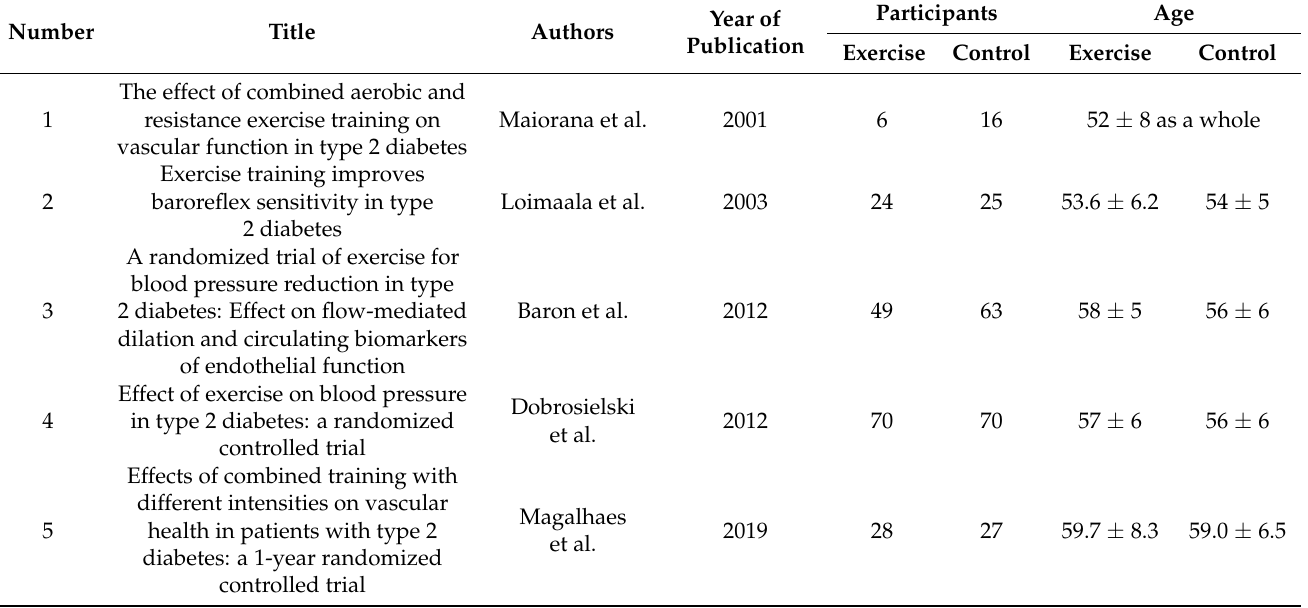
Table 1. Basic characteristics of included